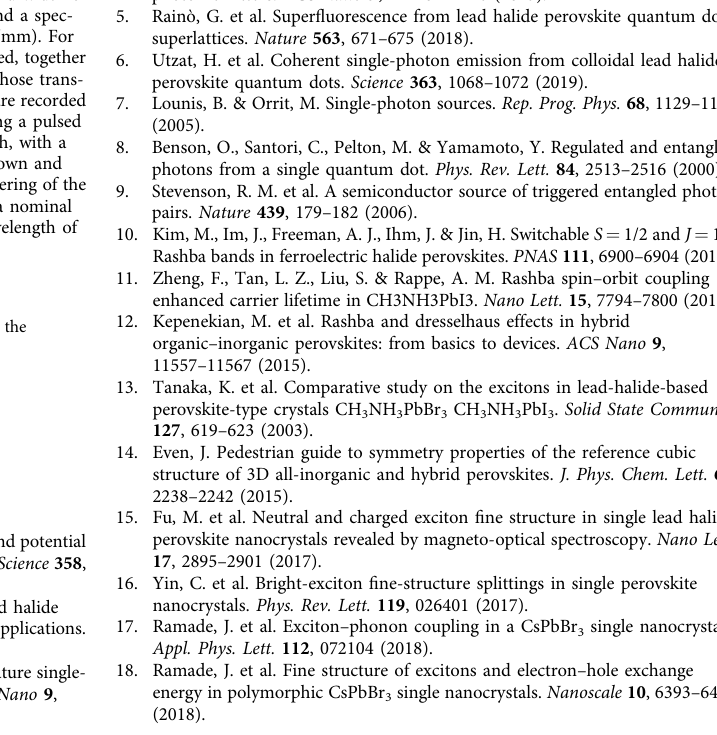
passed through a clean-up fi lter. The emitted photons are fi ltered from the scat- tered laser light with a band-pass fi lter (centered at 700nm with a band width of 70nm) and sent to a single-photon counting avalanche photodiode and a spec- trograph (with a resolution of ~120µeV using a grating of 1800 lines/mm). For resonant PL excitation spectra, a single-mode tunable Ti:Sa laser is used, together with a long-pass fi lter (with a nominal edge wavelength of 715 nm) whose trans- mission curve is tunable under a tilt of the incidence angle. PL decays are recorded with a conventional time-correlated single-photon-counting setup using a pulsed laser source (optical parametric oscillator at 561 nm, 200 fs pulse width, with a repetition rate reduced to 8MHz with a pulse-picker). A Hanbury Brown and Twiss setup is used to build the start – stop coincidence histograms. Filtering of the exciton or biexciton ZPLs is performed with tunable long-pass (with a nominal edge wavelength of 715 nm) and short-pass (with a nominal edge wavelength of 720 nm) fi lters. Data availability All relevant data that support our experimental fi ndings are available from the corresponding author upon reasonable request.